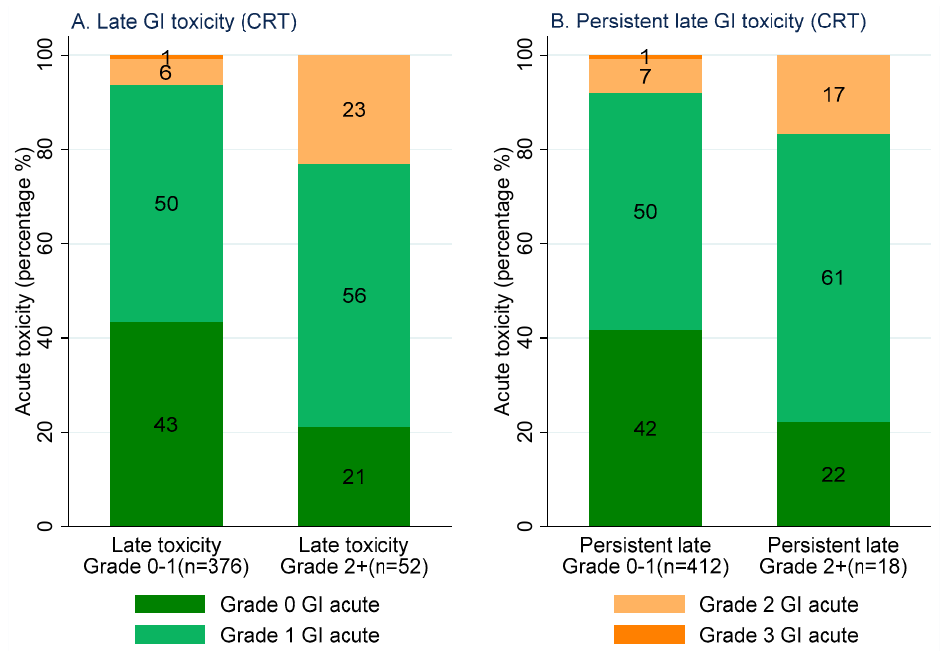
Figure 4. Stacked bar graph: maximum grade CTCAE acute GI toxicity experienced for patients with Grade 0–1 (left of each figure) and Grade 2+ (right of each figure) late GI toxicity following CRT (left). Maximum grade CTCAE acute GI toxicity experienced by patients with grade 0–1 (left of each figure) and grade 2+ (right of each figure) persistent late GI toxicity following CRT (right).